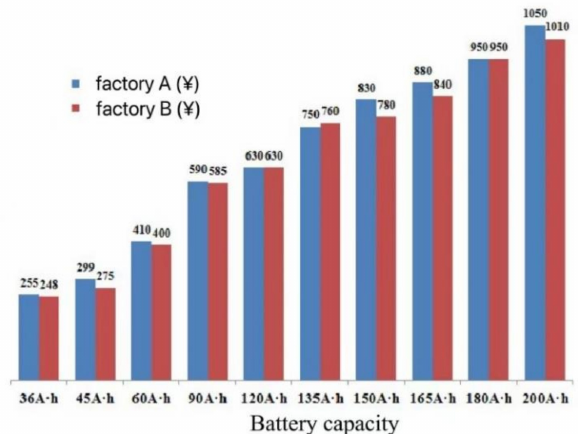
Figure 19. Price comparison charts of manufacturer A and manufacturer